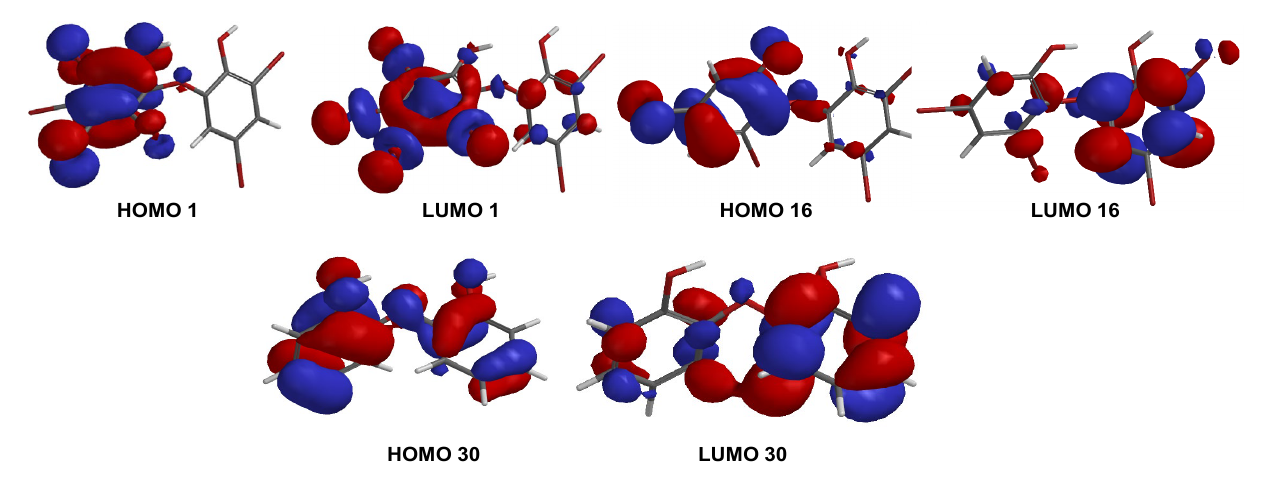
Figure 9. FMOs (HOMO and LUMO) for 1 , 16 , and 30 .